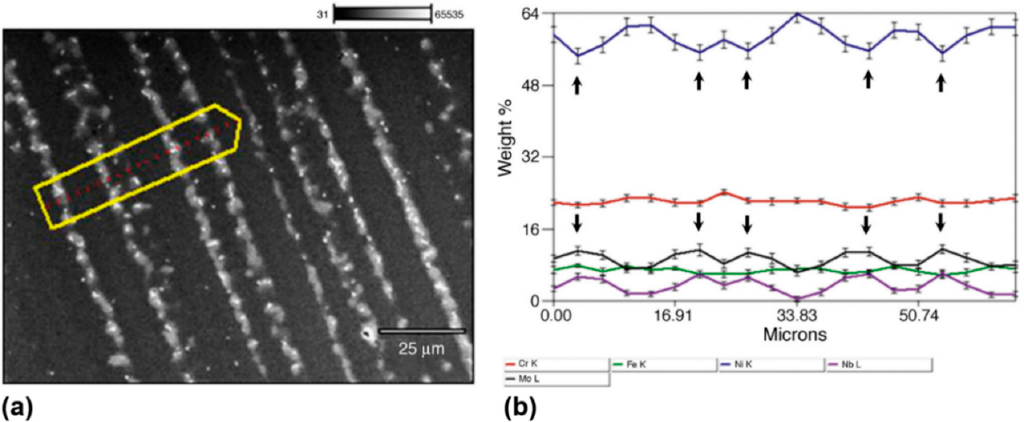
Figure 9. ( a ) Elemental chemical profile crossing dendrites, as shown by SEM, and ( b ) elemental segregation during solidification process, as shown by EDS (energy-dispersive X-ray spectroscopy). The arrows indicate the interdendritic regions [51].